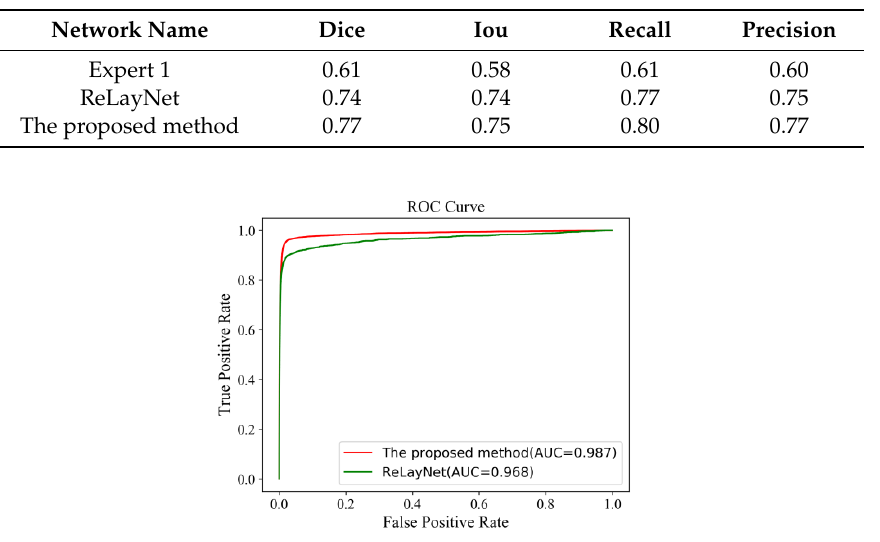
Figure 20. Comparison of ROC curves for diverse edemas in multi-regions and the expert 2 annotations as the ground truth.